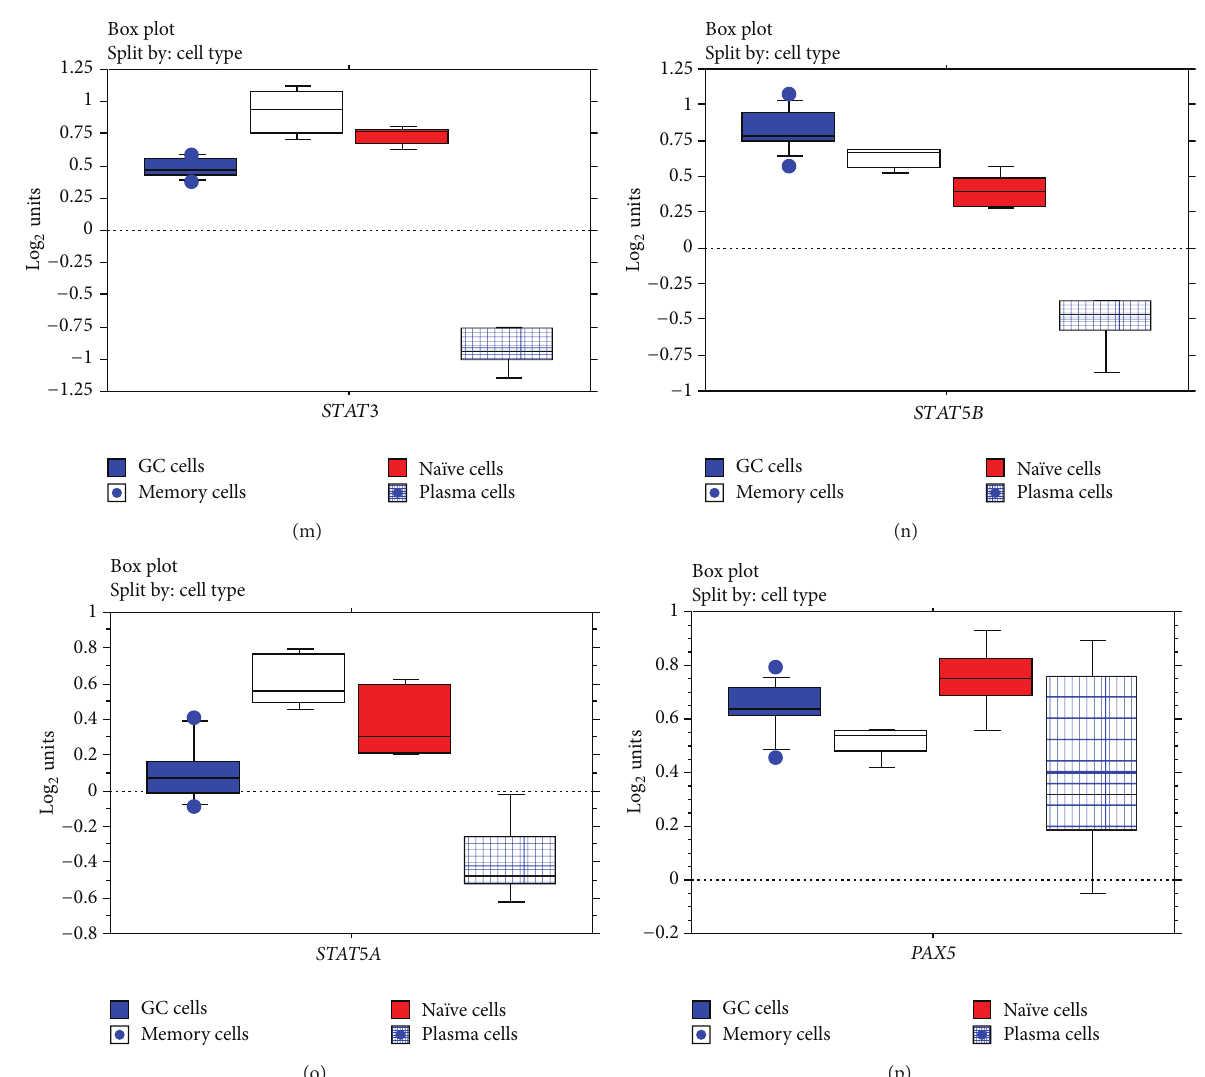
Figure 4: Gene expression levels of B-cell development associated transcription factors in normal B-lymphocytes. Normalized mRNA expression evaluated by GEP is presented in box